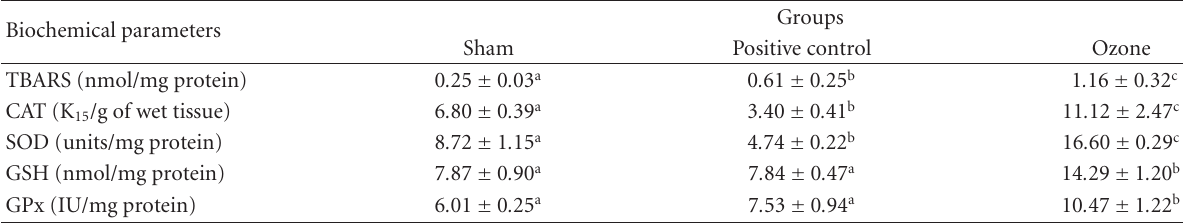
Table 3. Renal concentration of di ff erent biochemical parameters, thiobarbituric acid reactive substances (TBARS), catalase (CAT), superoxide dismutase (SOD), reduced glutathione (GSH), and glutathione peroxidase (GPx), at the end of the study in the experimen- tal groups. One unit of SOD enzymatic activity is equal to the amount of enzyme that diminishes the initial absorbance of nitroblue tetrazolium by 50% and CAT activity is described as the enzymatic activity quantity that transforms 1mol of H 2 O 2 , at room temper- ature, at 15 min/g of wet tissue. International units are expressed as µ mol of transformed hydroperoxides/min/mL of GPx. a , b , and c denote statistical significance of at least P < .